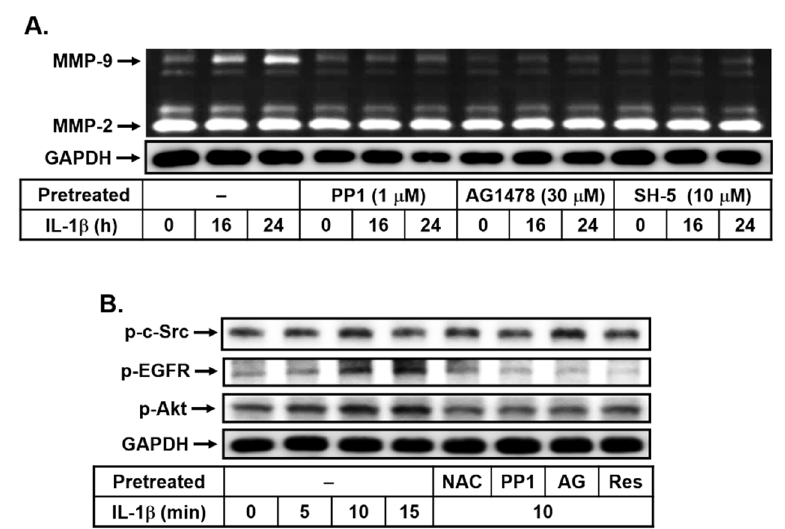
Figure 3. Resveratrol inhibits IL-1 β -induced MMP-9 expression via blocking Nox/ROS-mediated c-Src-dependent transactivation of EGFR in bEnd.3 cells. ( A ) The c-Src-dependent transactivation of EGFR was involved in IL-1 β -induced MMP-9 expression; cells were pretreated with PP1 (1 μ M), AG1478 (30 μ M), and SH-5 (10 μ M) and then stimulated with IL-1 β (10 ng/mL) for 0, 16, and 24 h. ( B ) IL-1 β stimulates a c-Src-dependent transactivation of EGFR/Akt pathway. Cells were pretreated without or with NAC (10 mM), PP1 (1 μ M), AG1478 (AG, 30 μ M), and Res (1 μ M) for 1 h before exposure to IL-1 β (10 ng/mL) for the indicated times. The conditioned media were collected and analyzed as described in Figure 1A. The cell lysates were analyzed for phosphorylation of c-Src (p-c-Src), EGFR (p-EGFR), Akt (p-Akt), and GAPDH by Western blot, as described in Methods. The image represents one of three individual experiments. 3.4. Effects of Resveratrol on IL-1 β -Induced MMP-9 Expression via the ROS-Mediated c-Src-Dependent EGFR Linking to MAPKs Cascade Activation of MAPKs could regulate several functions of brain cells [31]. Moreover, many reports have shown that MAPKs, including ERK1/2, p38, and JNK1/2, are critical for the IL-1 β -upregulated MMP-9 in brain astrocytes [18]. Thus, to determine whether MAPKs participate in IL-1 β -induced MMP-9 expression, the bMECs were pretreated with or without U0126 (1 μ M), SB202190 (SB, 30 μ M), or SP600125 (SP, 10 μ M) for 1 h and then incubated with IL-1 β (10 ng/mL) for the indicated time intervals. As shown in Figure 4A, pretreatment with U0126, SB202190, or SP600125 attenuated IL-1 β -induced MMP-9 expression, suggesting that MAPKs (i.e., ERK1/2, p38, and JNK1/2) may be involved in IL-1 β -induced MMP-9 expression in bMECs. We further demonstrated that IL-1 β stimu- lated the time-dependent phosphorylation of MAPKs (i.e., ERK1/2, p38, and JNK1/2) with a maximal response at 5 min and maintained over 15 min (Figure 4B), and this was attenuated by pretreatment with respective specific inhibitor of MAPKs by Western blot analysis. These results suggested that IL-1 β -induced MMP-9 expression is mediated via MAPKs (i.e., ERK1/2, p38, and JNK1/2) pathways in bMECs. Next, to determine whether IL-1 β -stimulated phosphorylation of MAPKs is mediated through the ROS-mediated c-Src-dependent EGFR cascade, cells were pretreated with NAC (10 mM), PP1 (1 μ M), or AG1478 (AG, 30 μ M) and then incubated with IL-1 β (10 ng/mL) for 15 min. As shown in Figure 4C, pretreatment with NAC, PP1, or AG1478 significantly inhibited IL-1 β -stimulated phosphorylation of MAPKs (i.e., ERK1/2, p38, and JNK1/2), suggesting that IL-1 β stimulated the phosphorylation of MAPKs (i.e., ERK1/2, p38, and JNK1/2) via the ROS-mediated activation of c-Src/EGFR pathway in these cells. Furthermore, we evaluated the effect of resveratrol in the IL-1 β -stimulated phosphorylation of MAPKs (i.e., ERK1/2, p38, and JNK1/2). The results showed that the pretreatment with resveratrol (Res, 1 μ M) markedly reduced IL-1 β -stimulated phosphorylation of MAPKs (i.e., ERK1/2,